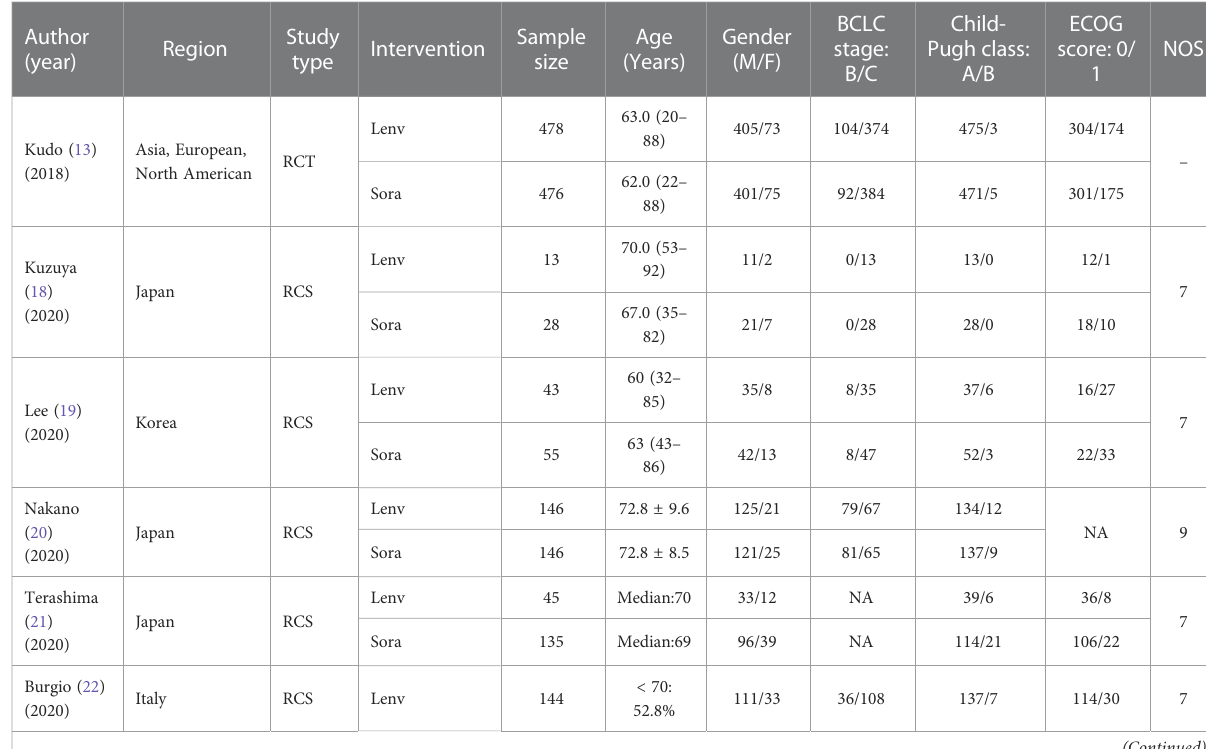
TABLE 1 Characteristics of the included